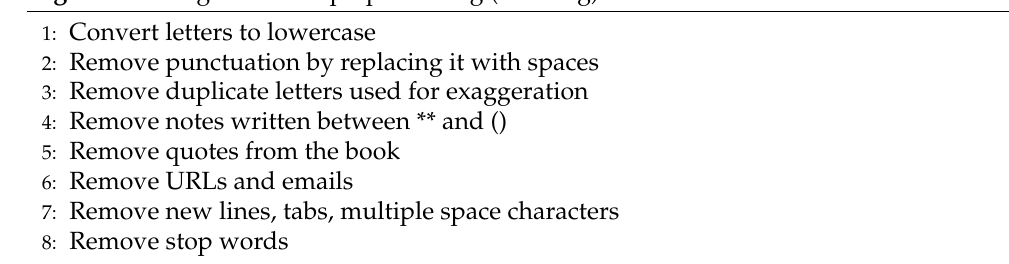
Algorithm 1 Algorithm for preprocessing (cleaning) the review